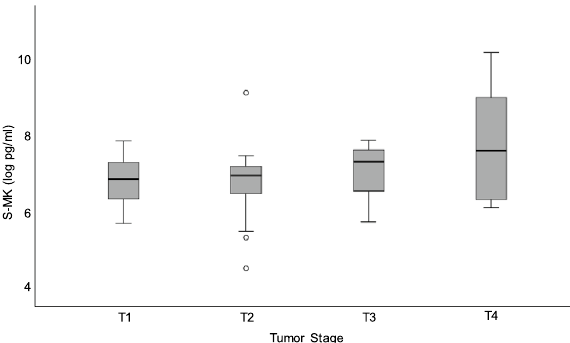
Figure 5. Trend towards increasing S-MK levels with NSCLC tumor stage progression. Abbreviations: S-MK serum-midkine, NSCLC non-small lung cancer, pg picogram, ml milliliter. Data shown in box-and-whisker plot (median, 25th and 75th percentile, range, extreme values outside the range). The level of statistical significance was determined using Kruskal–Wallis one-way ANOVA (p = 0.42).